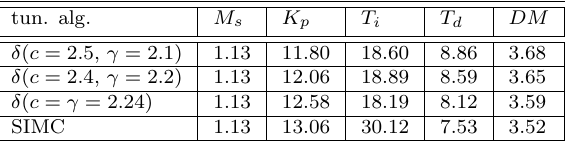
Table 9: Shows M s , the controller settings and the DM, for the δ -tuning and the SIMC rule, calcu- lated based on the approximated DIPTD pro- cess with K = 0 . 0027 and τ = 0 . 4231. The controller settings are used on the non-linear vessel model in Eq. (49). δ -tuning ( c = 2 . 5 and γ = 2 . 1) with δ = 3 . 6. SIMC tuning with T c = 7 . 9 τ .